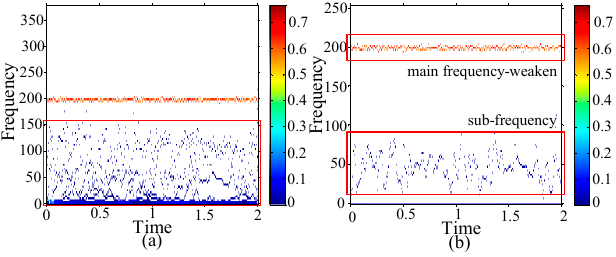
Figure 20. Holes of 1.0 mm on both inner and outer race ( a ) HHT spectrum ( b ) GEMD-HHT spectrum.